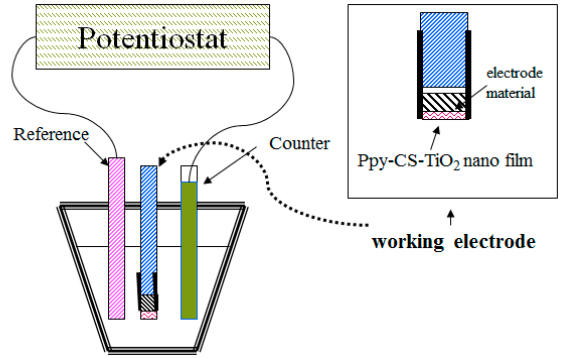
Figure 7. The electrochemical cell of Ppy-CS-TiO 2 film preparation.